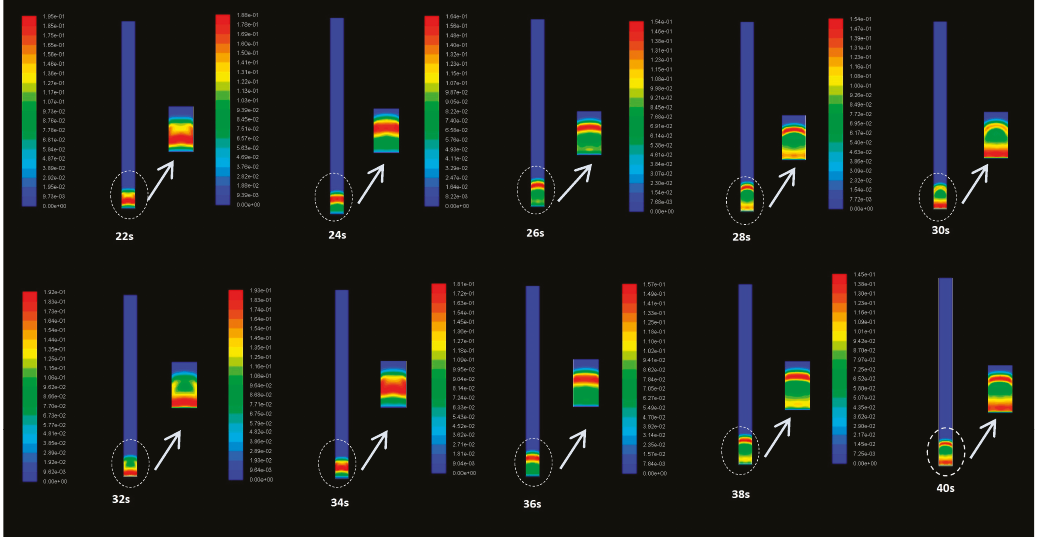
Figure 10. Solid volume fraction contour of Case 3 between 20 and 40